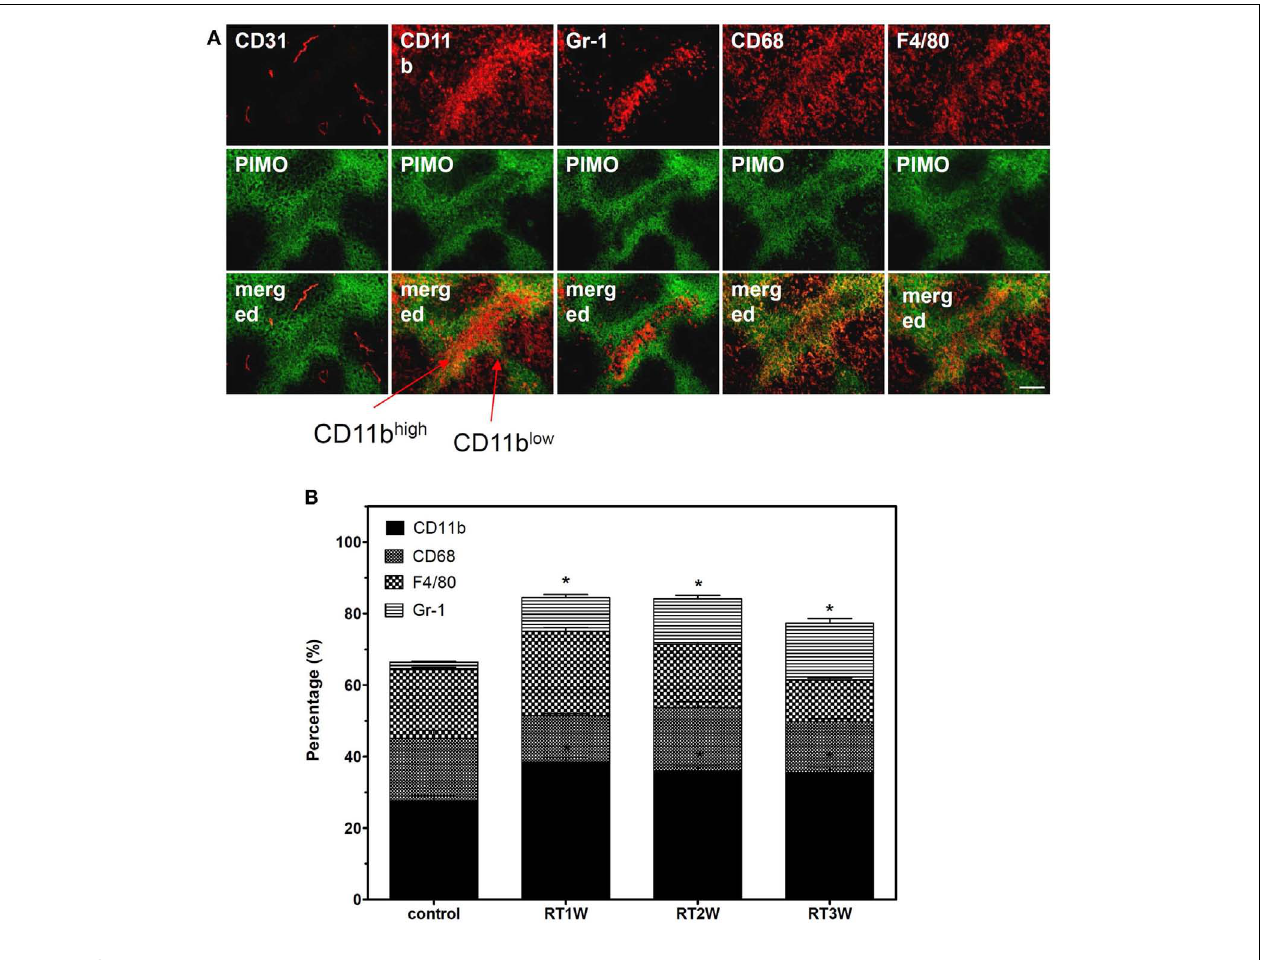
FIGURE 3 | Irradiation redistributes the localization of subtypes of inflammatory cells. (A) The distribution of CD31, CD11b, Gr-1, CD68, and F4/80 staining with PIMO + hypoxia in series 25Gy-irradiated-TRAMP-C1 tumor sections. Green: anti-PIMO stain for hypoxic region; red: anti-CD31, anti-CD11b, anti-Gr-1, anti-CD68,